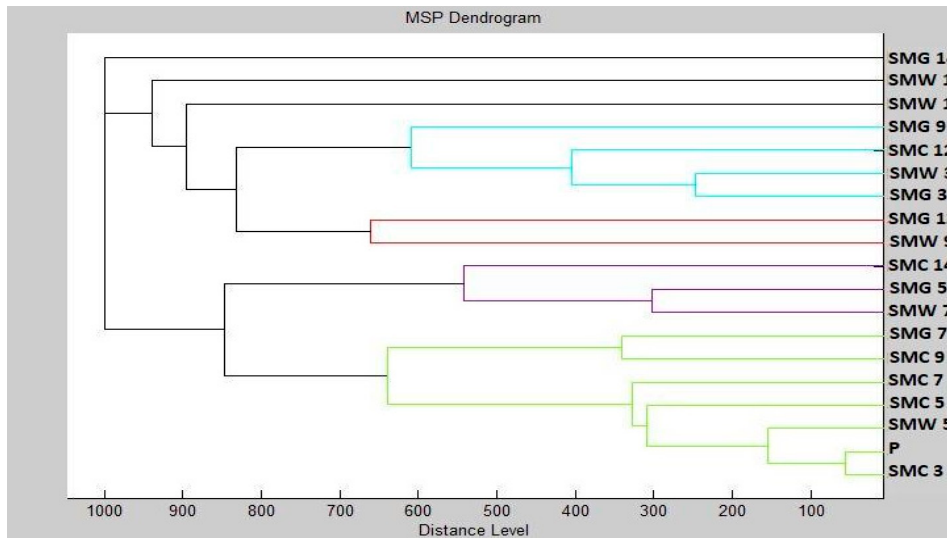
Figure 4. Dendrogram of S. maltophilia generated using MSPs of the planktonic cells and the control. SM, S. maltophilia ; C, control; G, glass; W, wood; and P, planktonic cells.